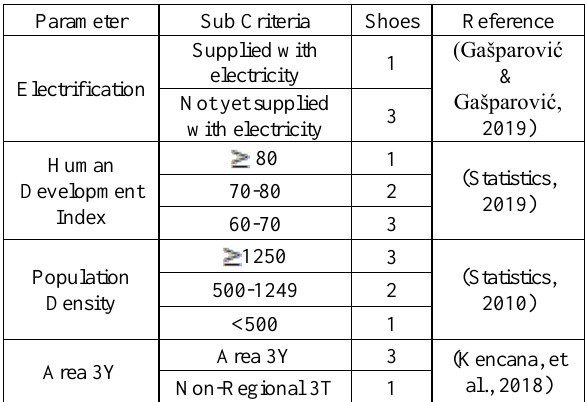
Table 3 Parameters and Criteria for Socioeconomic Aspects